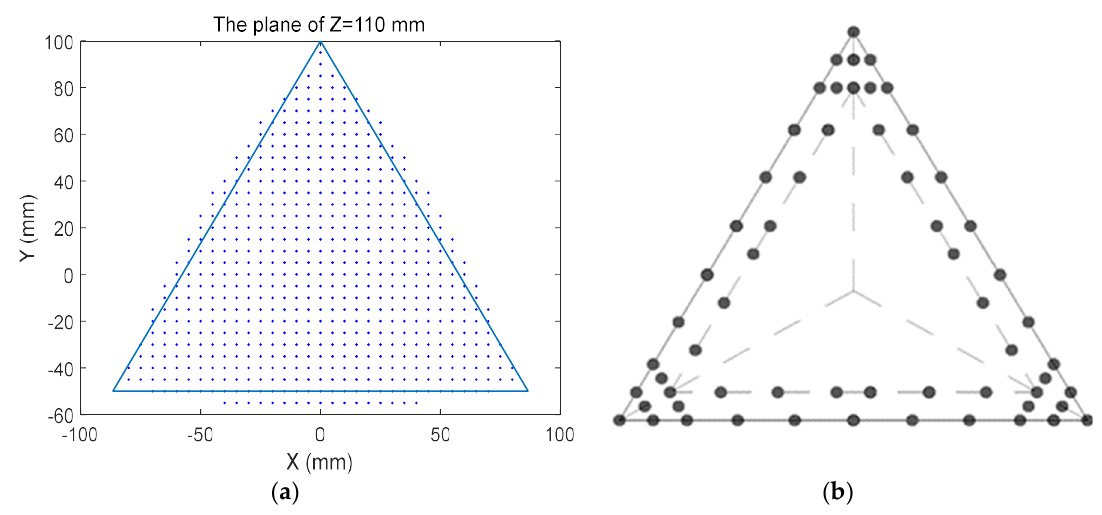
Figure 7. The distribution of candidate points: ( a ) The planform of Z = 110 mm; ( b ) Discretized boundary of the Z = 110 mm.